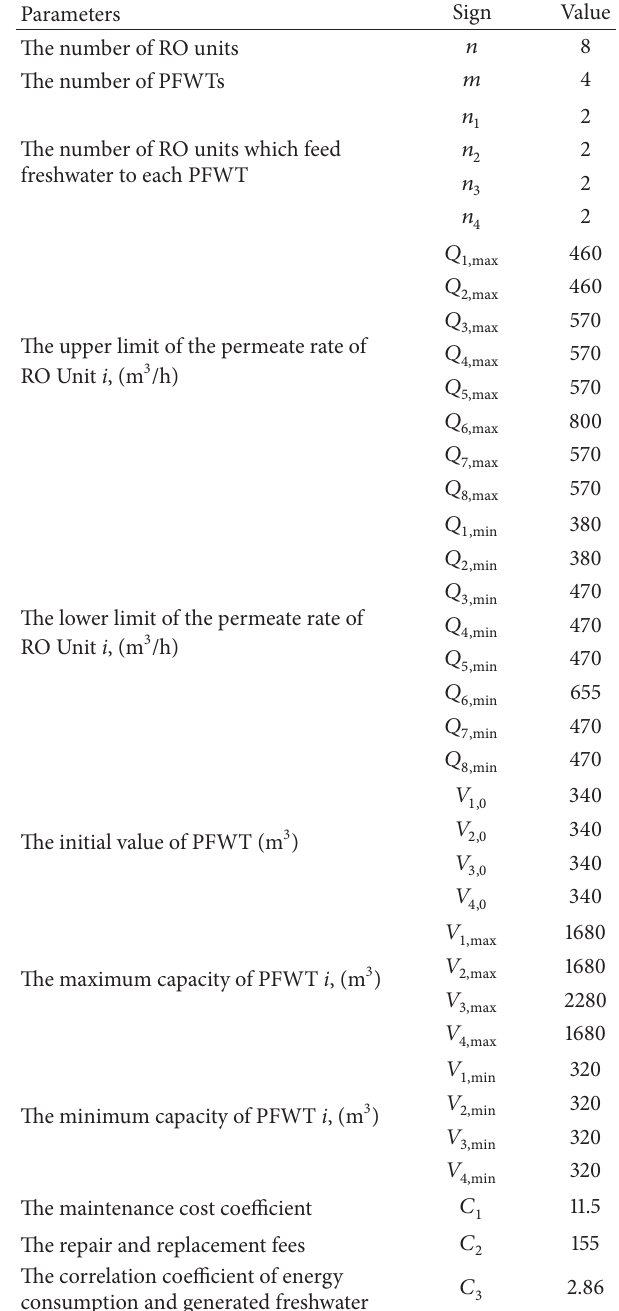
Table 1: The basic parameters of OOP in Liuheng SWRO desalina- tion